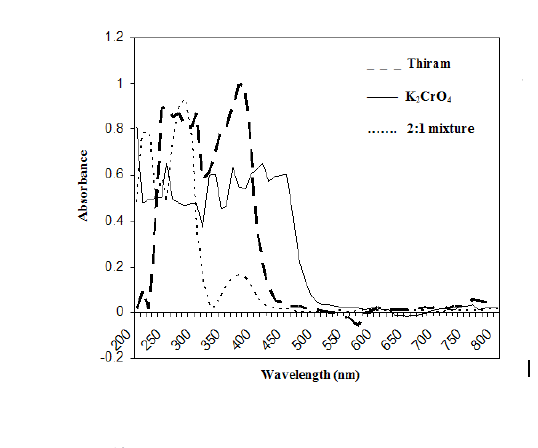
Figure 3: Continuous variation plot of absorbance vs volume mixing ratio of thiram: K solutions = 10 -4 mol L -1 ).